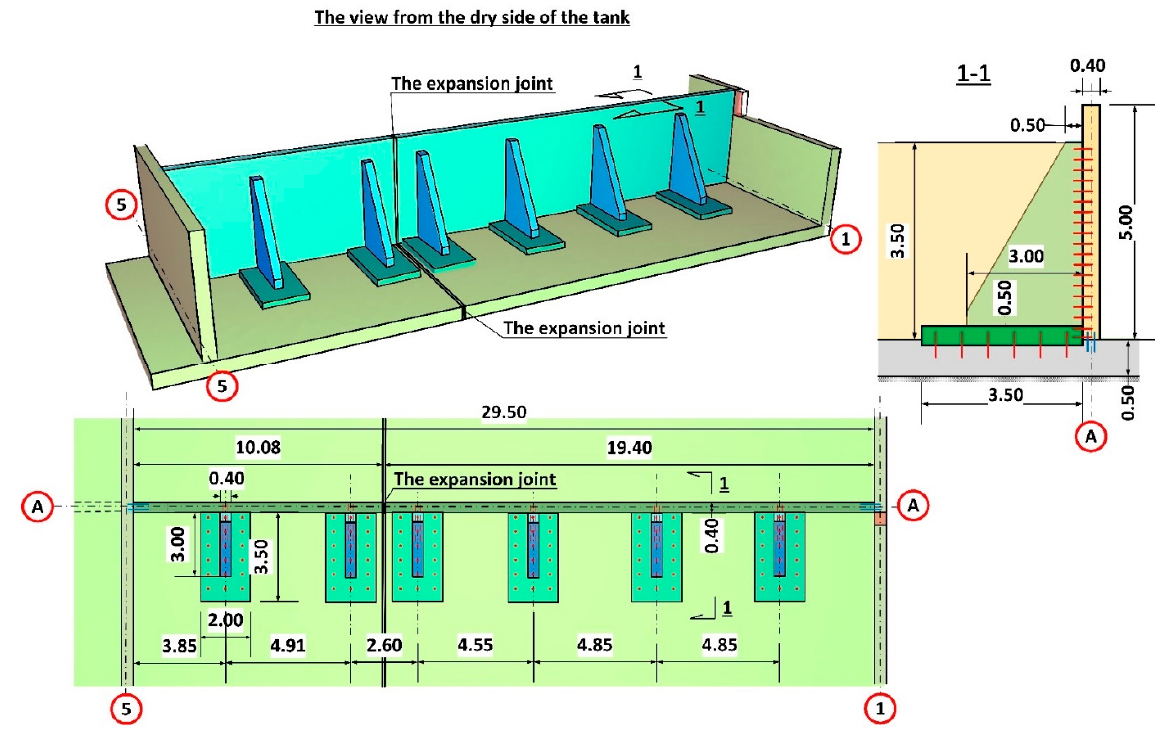
Figure 16. Support concept for the damaged wall in reactor no. 2.